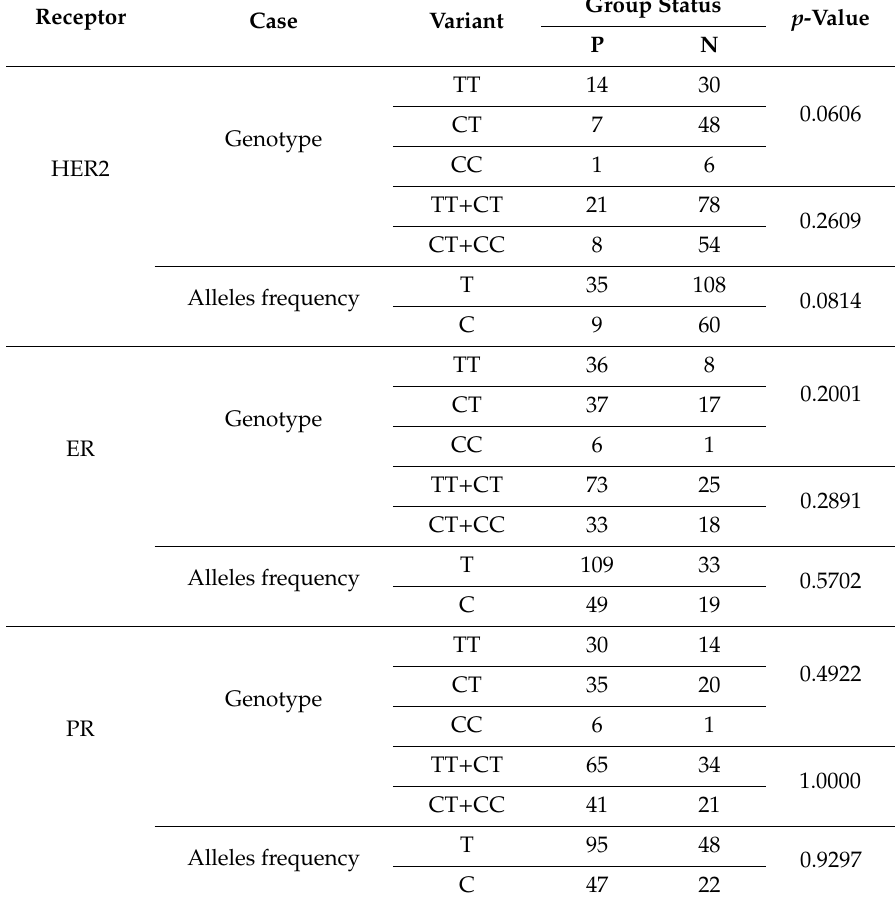
Table 2. The association analysis between miR-125a rs12976445 polymorphism and HER2, ER and PR receptors status in breast cancer patients. The association was calculated using χ square test. The status of receptors was divided into two groups-positive (P) and negative (N). Group Status Receptor Case Variant p